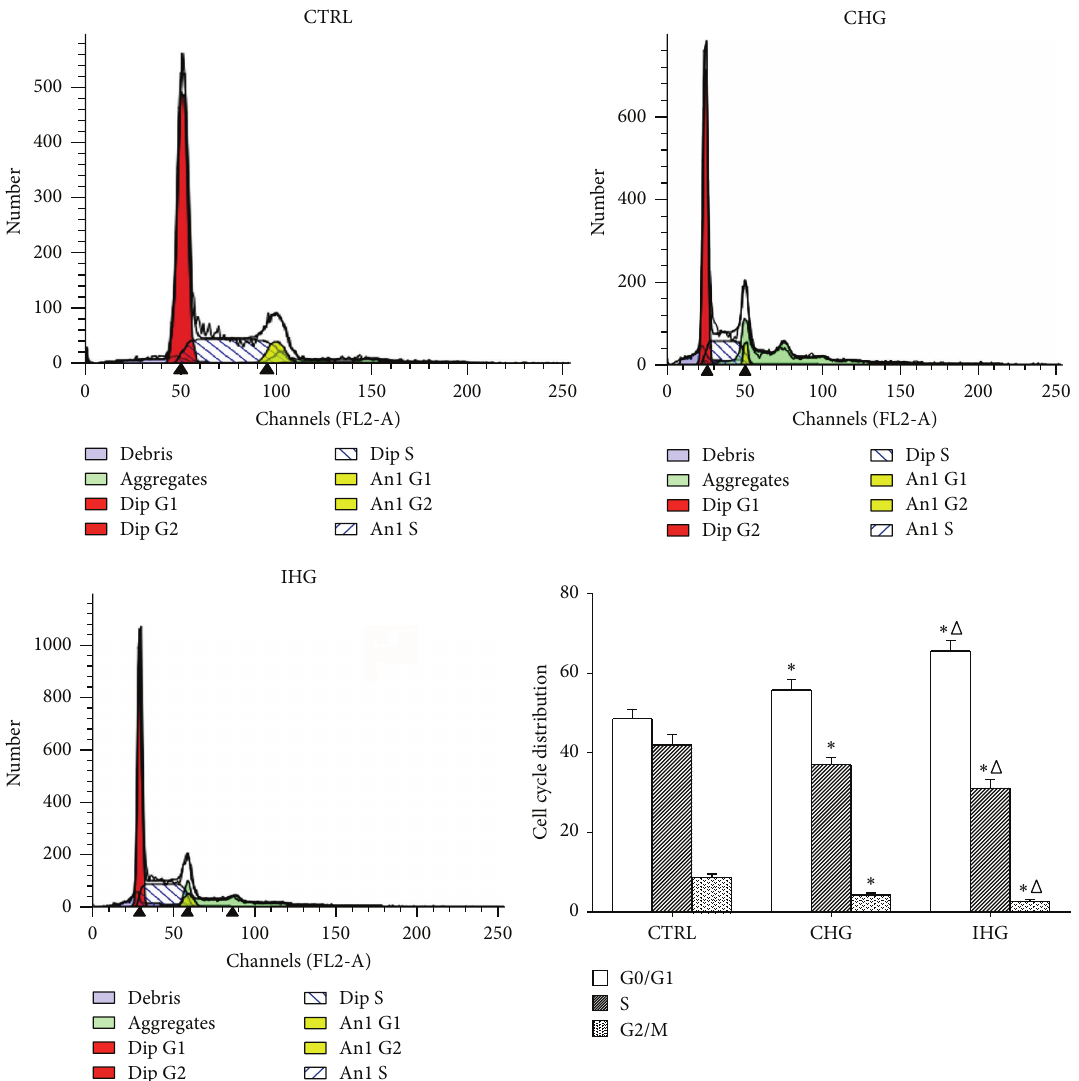
Figure 4: Determination of cell cycle with flow cytometry. After the treatment for 7 days, cells were collected for the detection of cell cycle according to the standard protocol. The distribution of cells in the different cell cycle phases was analyzed using Multicycle software. Data were expressed as mean ± SD of three determinations. Control, normal glucose; CHG, constant high glucose; IHG, intermittent high glucose. ∗ 𝑃 < 0.05 , and Δ 𝑃 < 0.05 respectively, indicate a significant difference from controls and